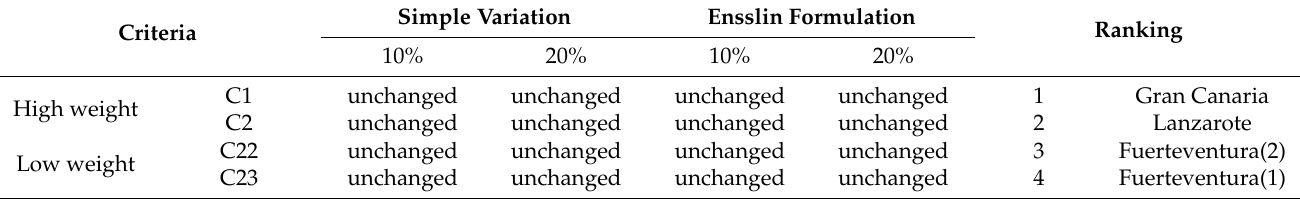
Table 8. Criteria relative importance in the different sensitivity analysis scenarios.